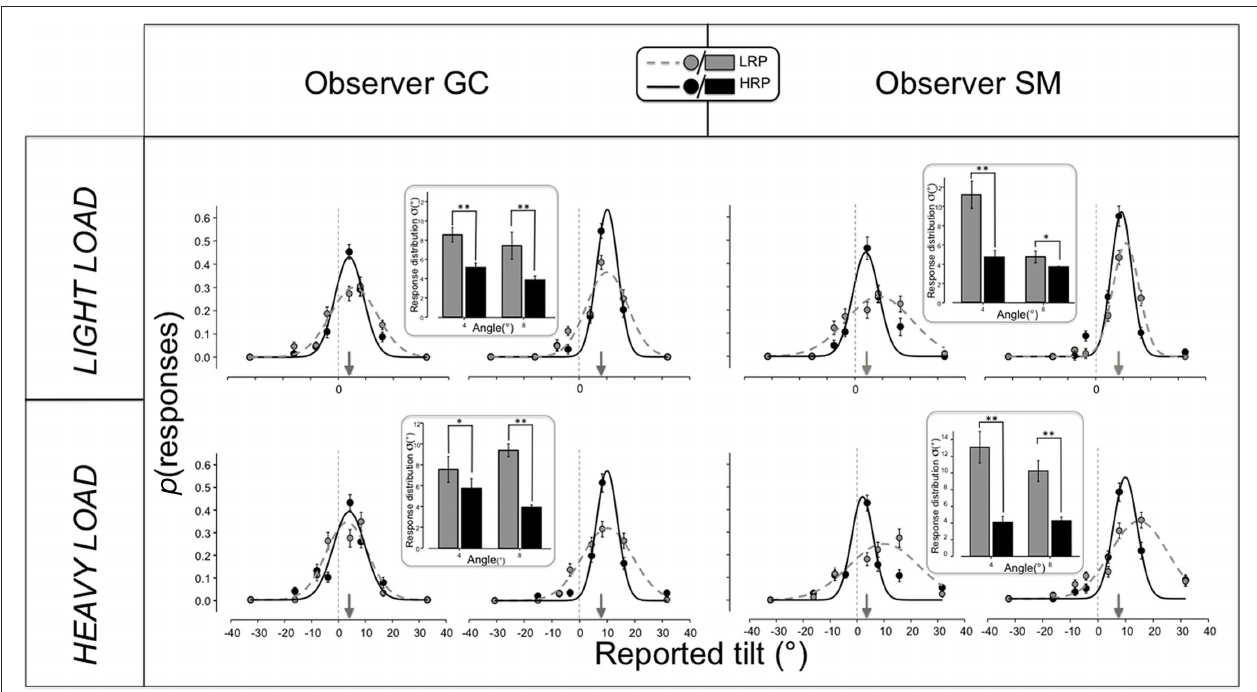
Figure 3 | Behavioral tuning functions obtained by two observers (Cg, left, and SM, right) in the two attentional load conditions (light load, top, and heavy load, bottom). Each table cells reports two pairs of graphs, for the two physical angles around threshold (4 ° and 8 ° , indicated by the gray arrows), that is the histogram of reported angles given an angle of 4 ° and of 8 ° , to the left and to the right of each panel, respectively. Each graph plots the functions measured for HRP trials (black symbols) and LRP trials (gray symbols), fitted with Gaussian pdf s (straight black and dashed gray, respectively; R 2 ≥ 0.78). The abscissae report negative angles for reported tilts yielding to errors, i.e., CCW identifications with CW signals and CW identifications for CCW signals collapsed together, and positive angles for correct discriminations. The error bars of each symbol represent the SEM of the estimate calculated by a bootstrap procedure (Efron and Tibshirani, 1994). The framed bar plots show the σ of the Gaussian fits with the error bars representing the SEM of the bootstrap estimates and the asterisks showing the significance